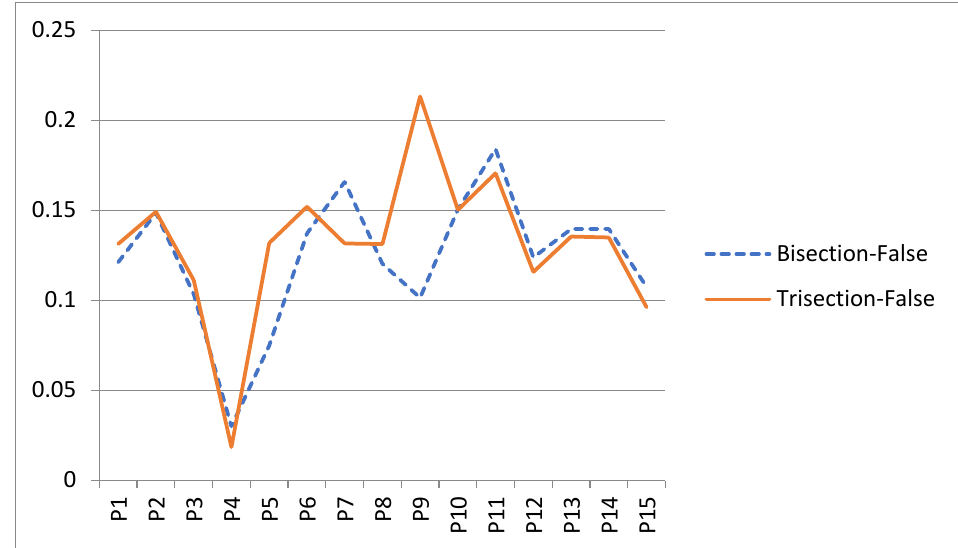
Figure 5. A comparison among 7 methods on 15 problems according to the CPU time.